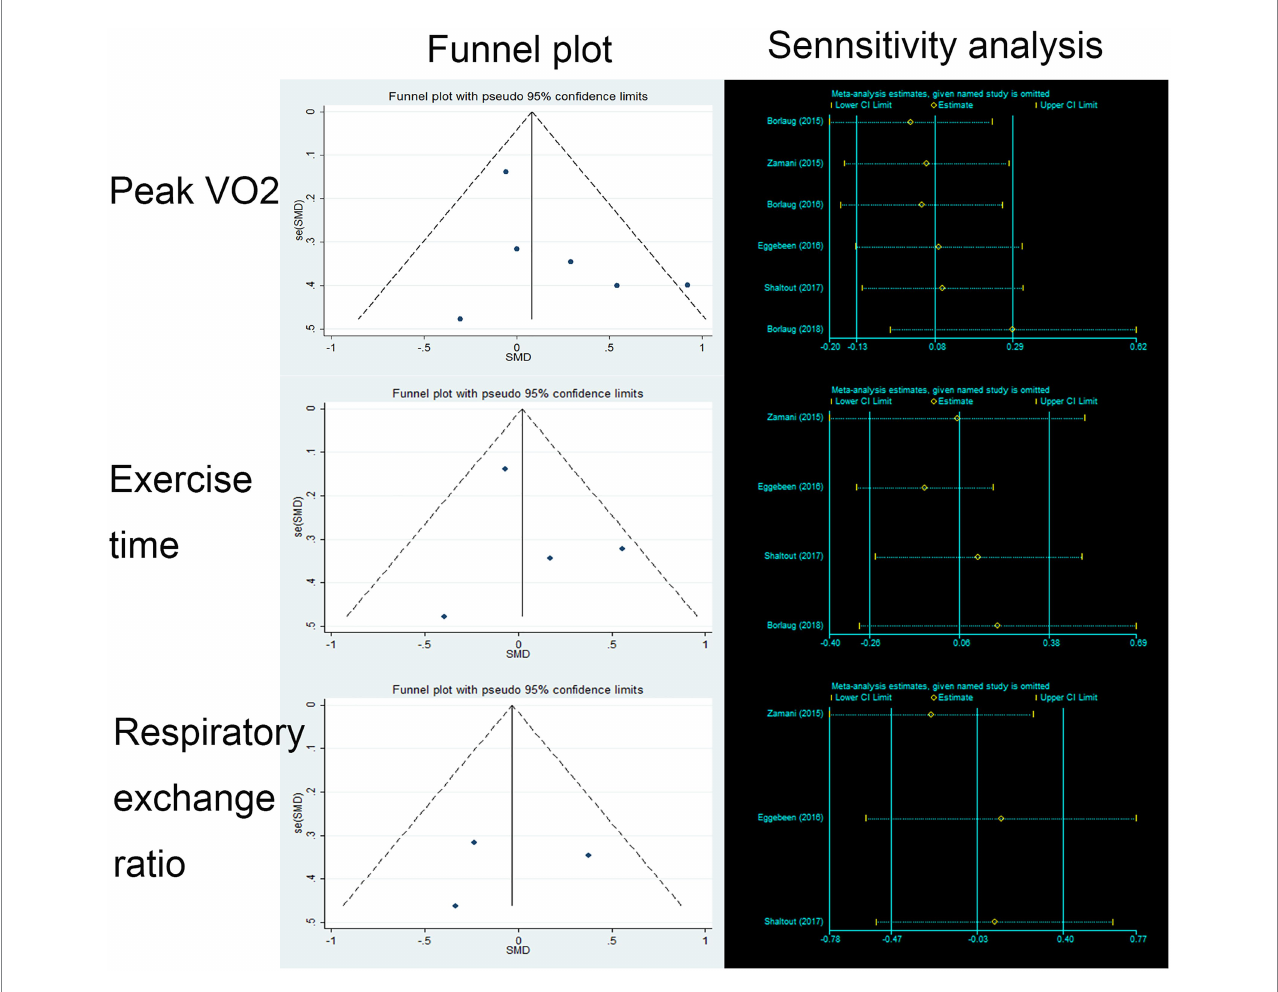
FIGURE 3 Funnel plot and sensitivity analysis of primary